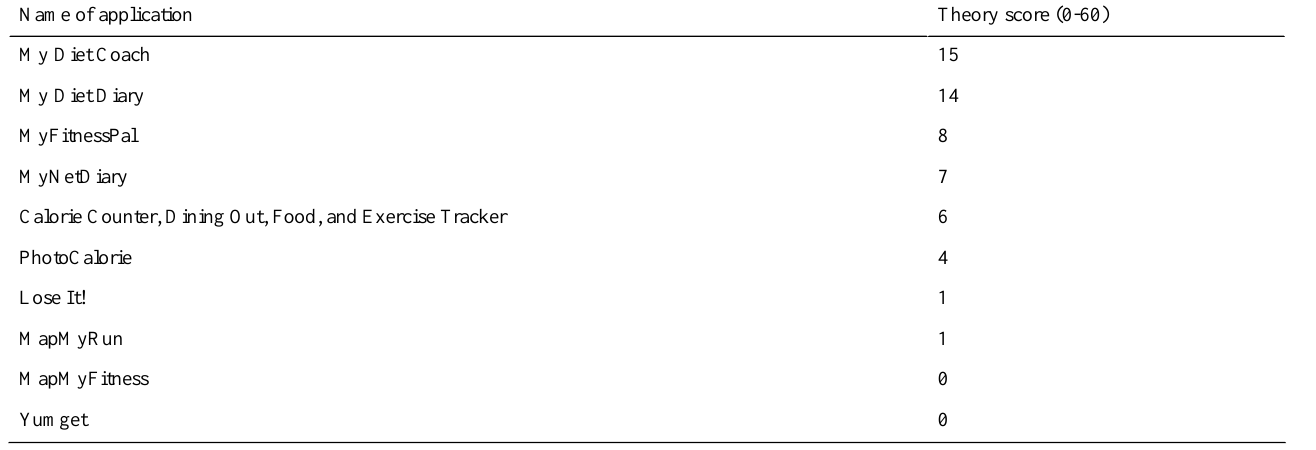
Table 2. Theory scores of selected calorie counting